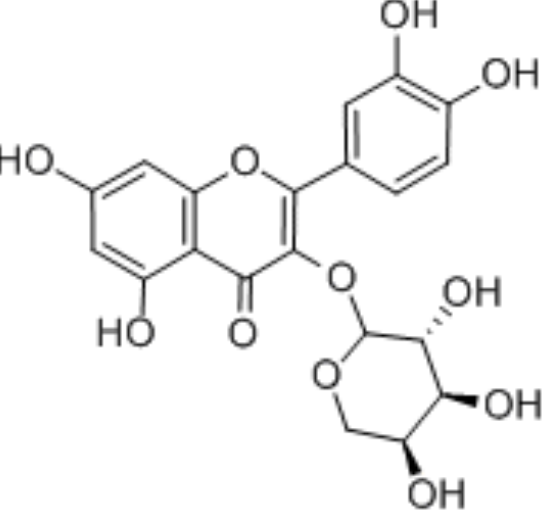
Figure 1. Structure of avicularin.